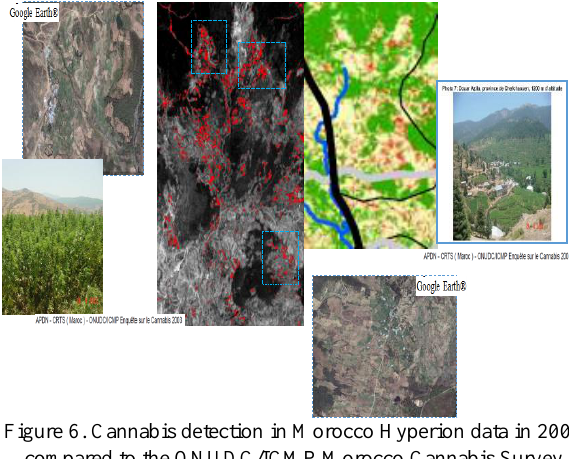
Figure 6. Cannabis detection in Morocco Hyperion data in 2003 compared to the ONUDC/ICMP Morocco Cannabis Survey report of the same year (UNODC, 2003), and Google Earth® high spatial resolution images (GoogleEarthPro, 2017a; GoogleEarthPro, 2017b)